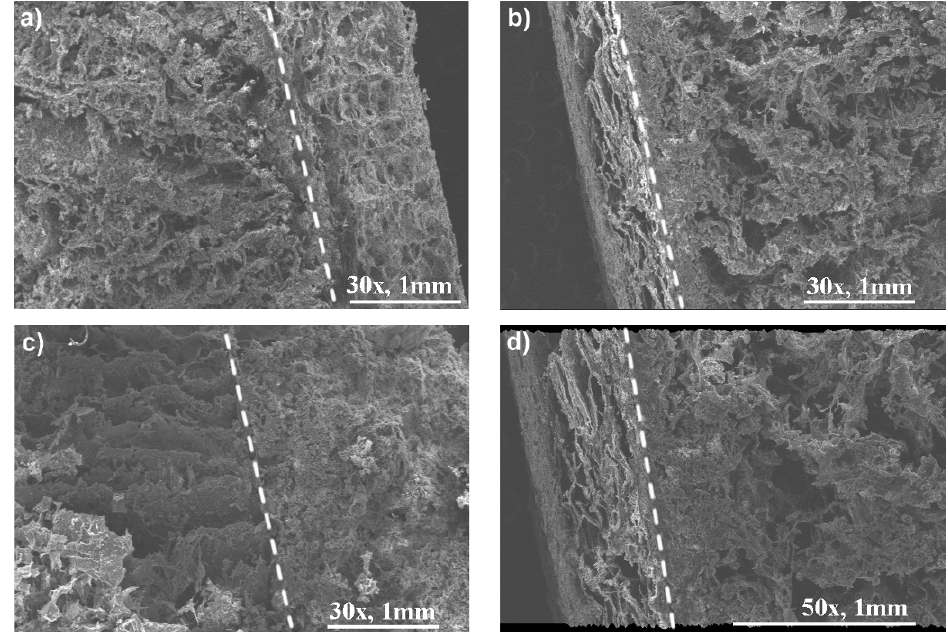
Figure 3. The SEM images of asymmetric, double-layered potential bone grafts obtained by assembling the two COLL/HA layers with different ceramic properties.